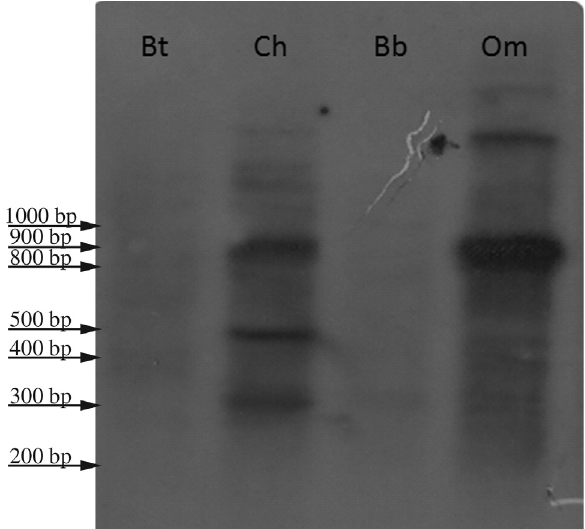
Figure 2 - Ovis orientalis musimon genomic DNA digested with Alu I and hybridized to probe Om1. Signals are detected in genera Ovis and Capra , but not in genera Bos and Bison . Abbreviations as in Figure